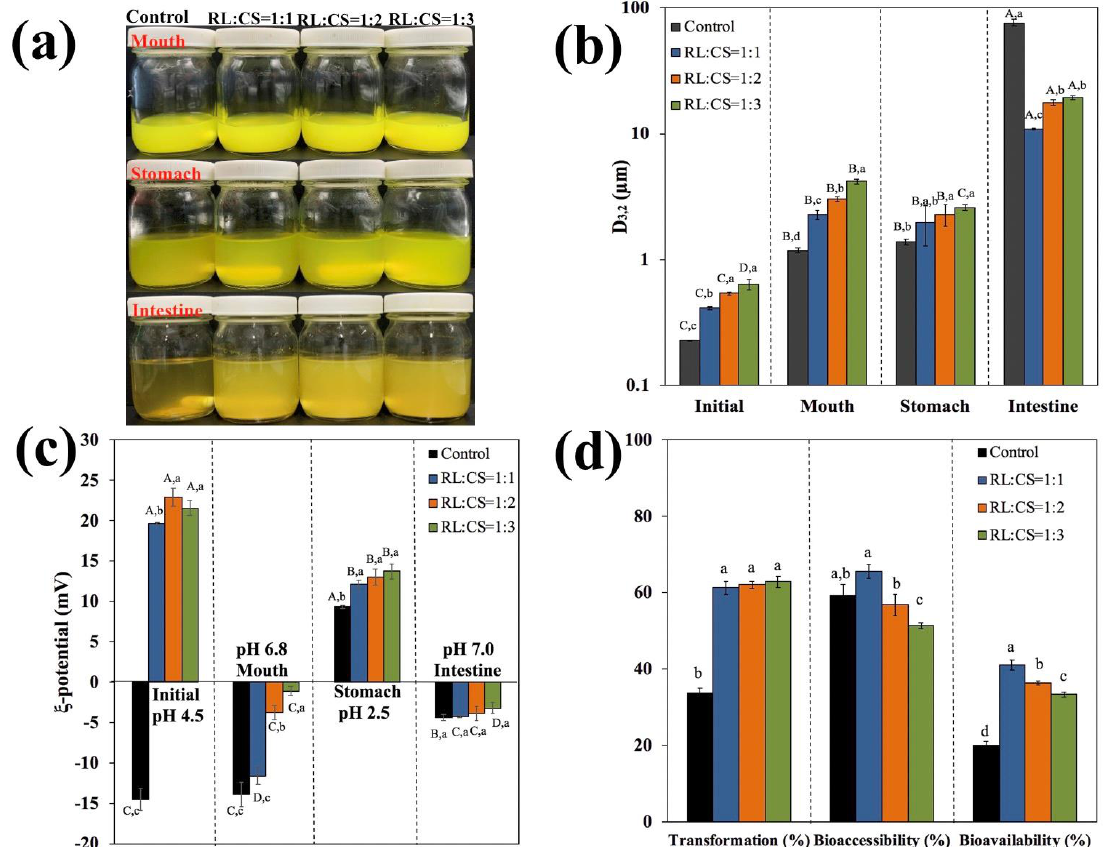
Figure 7. Visual appearance ( a ), particle size ( b ), ζ -potential ( c ) of Cur-loaded liposomes with different ratios of RL/CS during the digestion phases; ( d ) curcumin transformation, bioaccessibility and bioavailability percentages for Cur-loaded liposomes with different ratios of RL/CS during the digestion phases. Samples denoted by different capital case letters (A – D) were significantly different ( p < 0.05) when compared between different GIT regions (same RL/CS ratios). Samples denoted by lowercase letters (a – c) were significantly different ( p < 0.05) when compared between different RL/CS ratios (same GIT region).